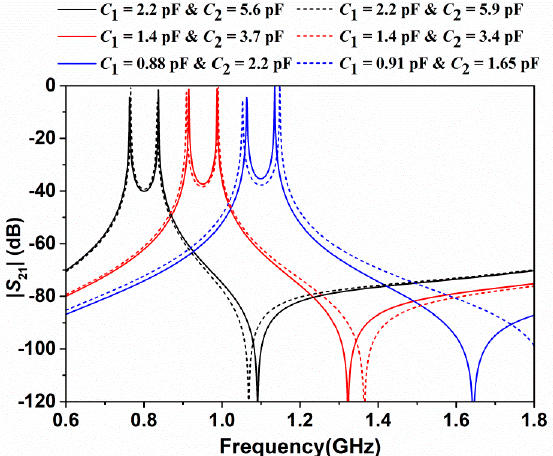
Figure 3. Typical response using week couple (solid line: 74 MHz CABW case; dash line: 8.5% CFBW case).